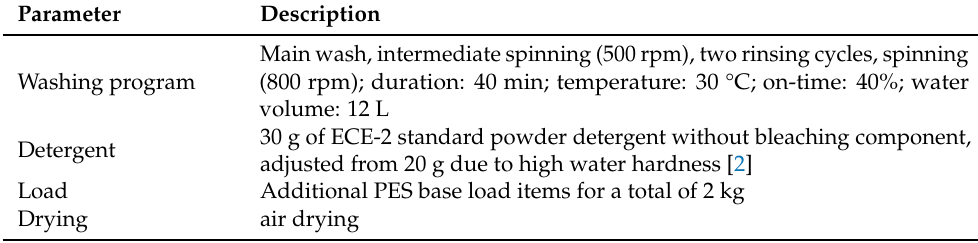
Table 3. Wash testing